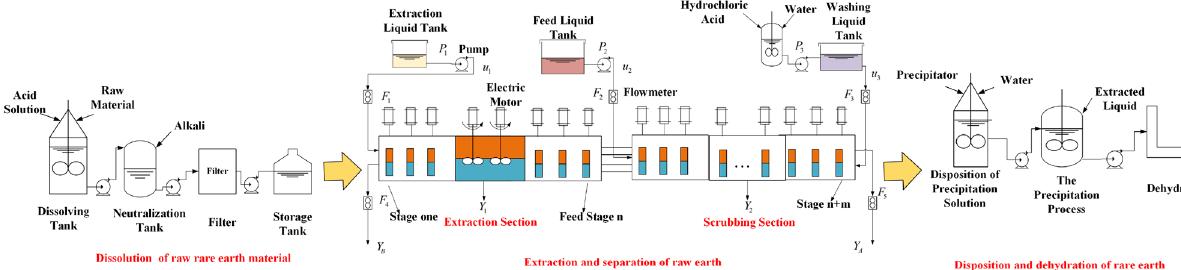
Figure 1. The Main procedure of rare earth production.